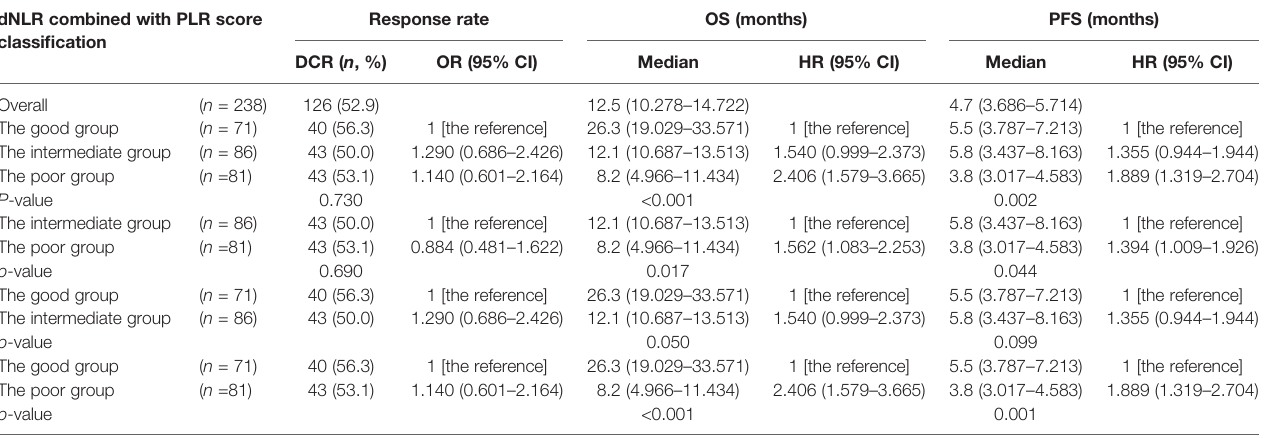
TABLE 6 | Ef fi cacy and prognosis based on the good, the intermediate, and the poor groups. dNLR combined with PLR score Response rate OS classi fi cation